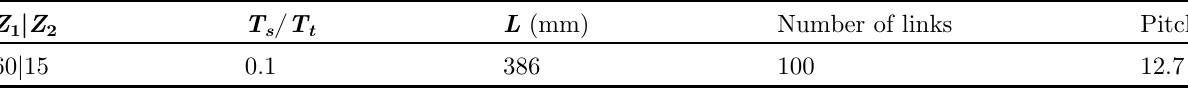
Table 1. Characteristics of the studied single speed